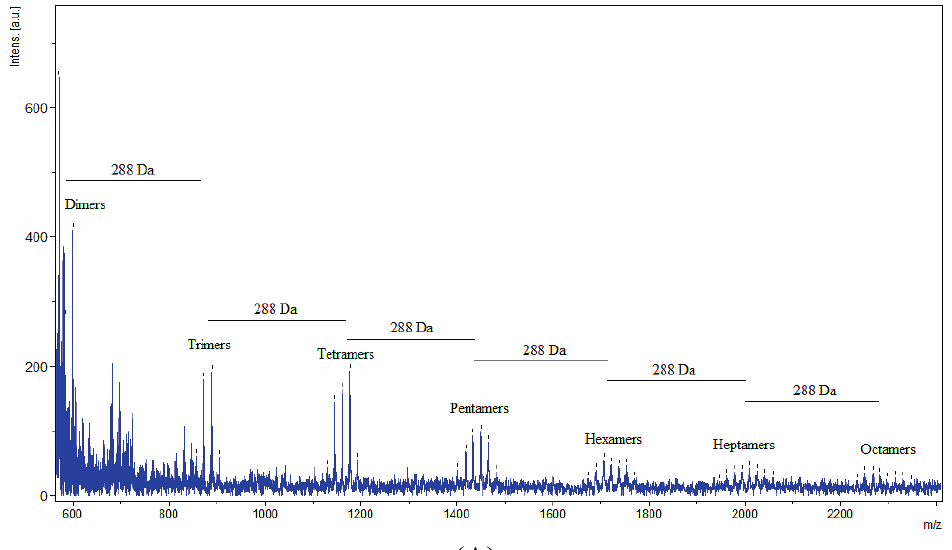
Figure 2. MALDI spectrum of proanthocyanidins extracted from Cecropia leaves. The distance between subsequent groups of peaks is 288 Da, the mass of an additional procyanidin unit. ( A ) Cecropia sciadophylla immature leaves (Na + ). ( B ) Cecropia sciadophylla mature leaves (Na + ). ( C ) Cecropia polystachya immature leaves (Na + ). ( D ) Cecropia polystachya mature leaves (Cs +